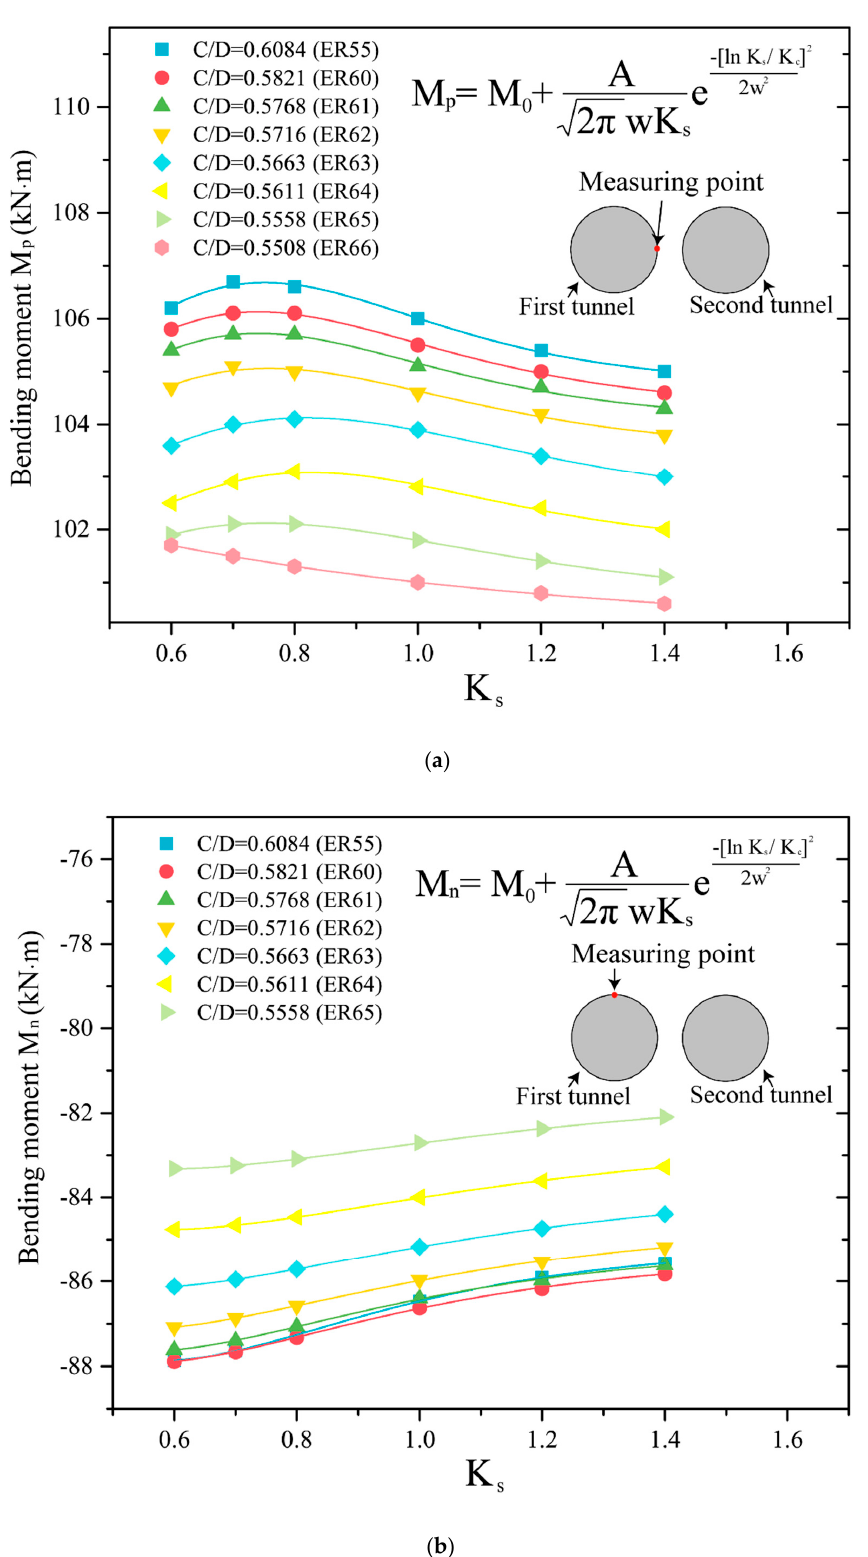
Figure 15. Influence of the face supporting pressure on the lining bending moment in different cases: ( a ) influence on the bending moment at the tunnel side-wall; and ( b ) influence on the bending moment at the tunnel top. Table 4. Parameters of each lognormal fitting curve.